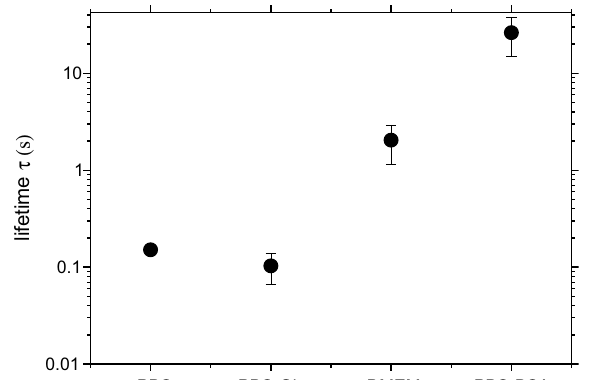
Figure 2. Lifetimes of the gas bubble in aqueous solutions with different solutes. The error bar shows standard deviation of the lifetime obtained from 10 bubbles each.